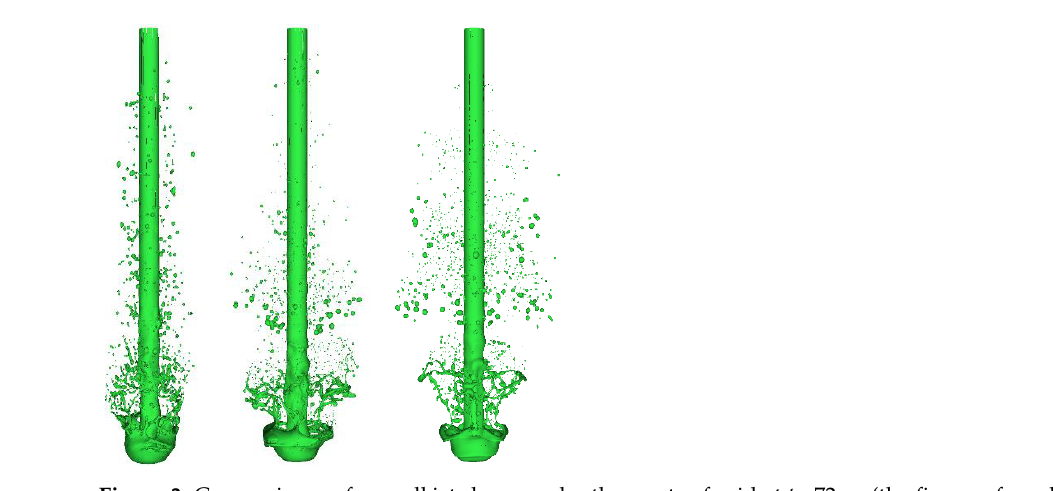
Figure 3. Comparisons of overall jet shape under three sets of grid at t =72 μs ( the figures, from left to right, represent cases 1, 2, and 3, respectively).